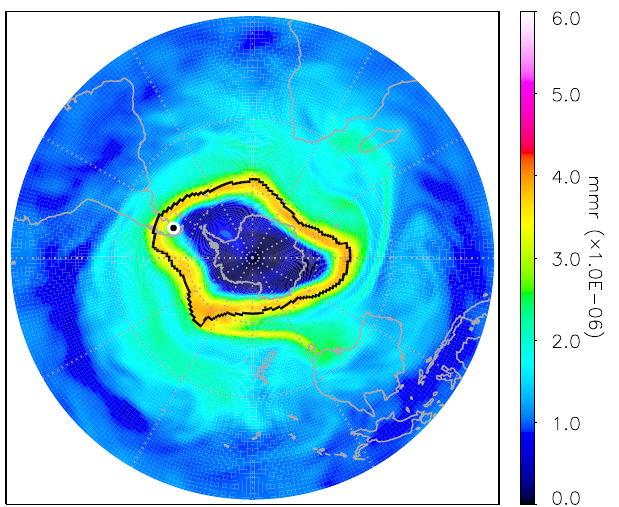
Fig. 18a. The vortex edge overplotted on top of the ERA-Interim ozone mass mixing ratio (mmr) at 430K for 26 September 2009. The location of Río Gallegos is indicated by the black-in-white cir- cle.